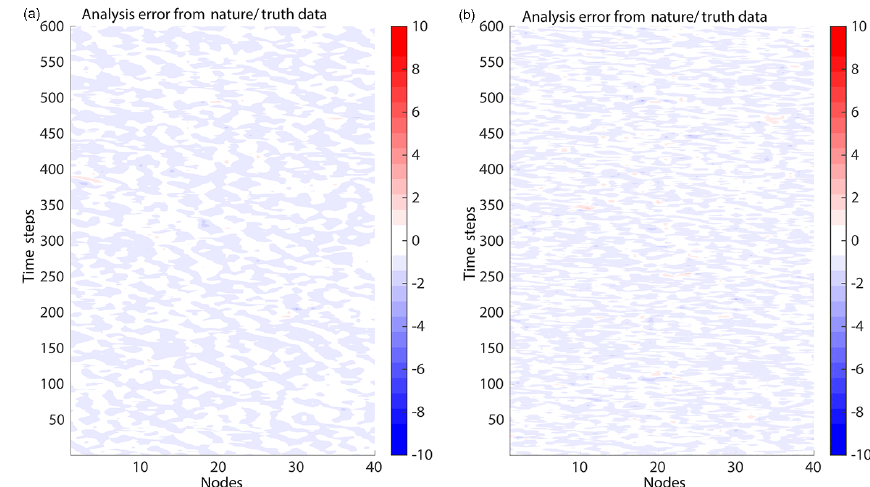
Figure 3. Analysis error for (a) LETKF and (b) LPF, using an analysis cycle window length d t = 0.05 (6h), localization radius r = 2 grid points, k = 40 ensemble members, and l = 20 observations sampled randomly on the domain (prescribed observation locations and errors are identical for both